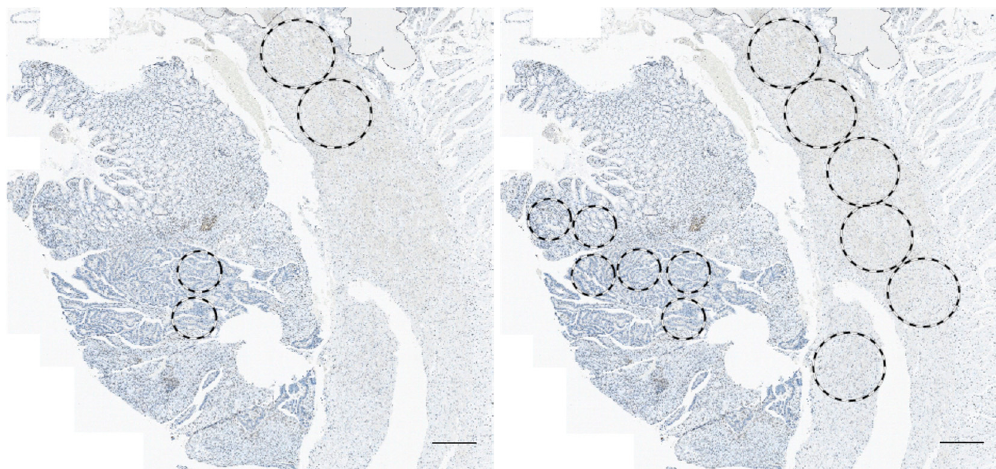
Figure 2. Virtual TMA establishment on scanned full section slides of rectal cancer (RC) samples using StrataQuestTM ® . ( Left ): Randomly selected virtual cores in the central tumor (2x 0.6mm diameter) and in the invasive margin (2x 1mm diameter) on full section slides of RC samples. ( Right ) : Expansion of virtual core establishment from 2 to a maximum of 6 cores per tumor region taking into account the minimum amount of tumor area available amongst all full section slides. Note. Bar graph = 500 µm.